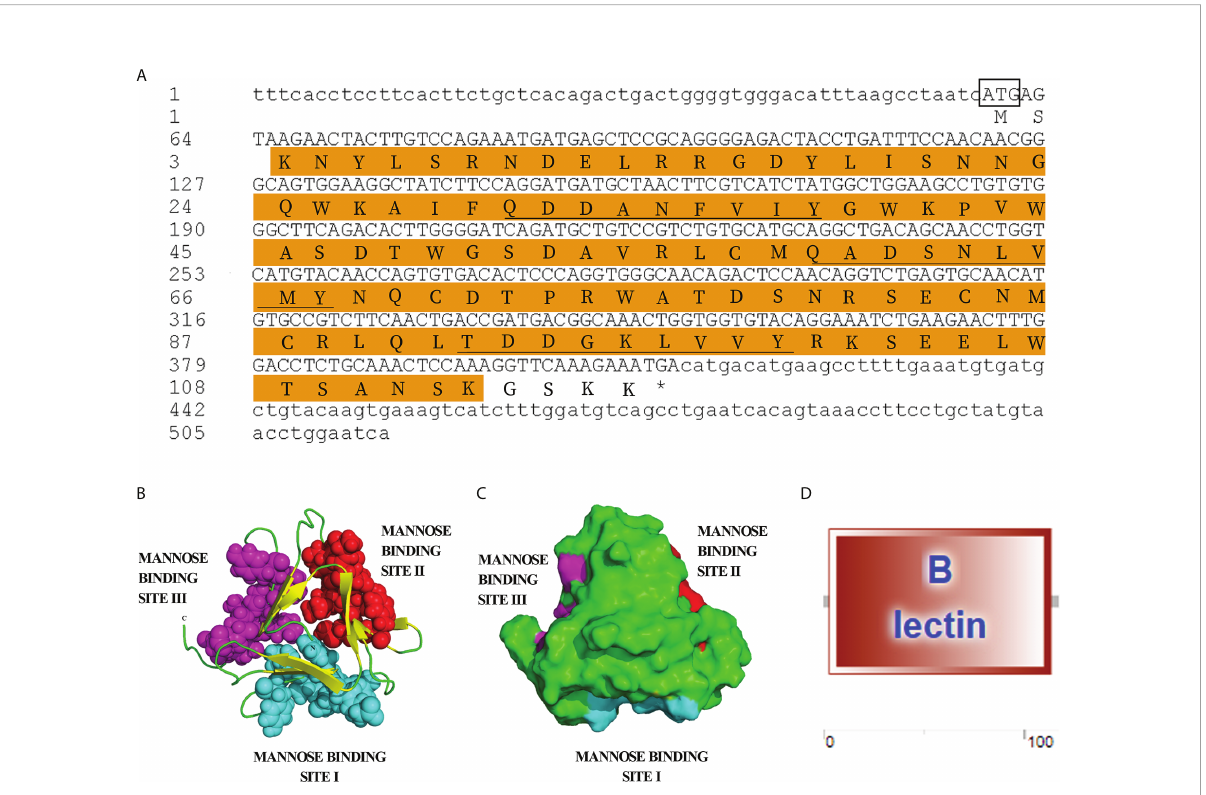
FIGURE 1 Nucleotide and protein structure of OppLTL. (A) Nucleotide sequence of OppLTL cDNA and deduced amino acid sequence. The start codon is boxed, and the stop codon is marked with an asterisk. The shaded part represents B-lectin domain, and the three D-mannose binding sites are underlined. (B) 3-D structure of OppLTL. Random coils are marked with green color, and yellow parts represent b -sheets. The D-mannose binding sites-1, -2, and -3 are represented in cyan-, red-, and purple-colored ball structure, respectively. (C) Surface view of OppLTL. (D) Predicted domain of